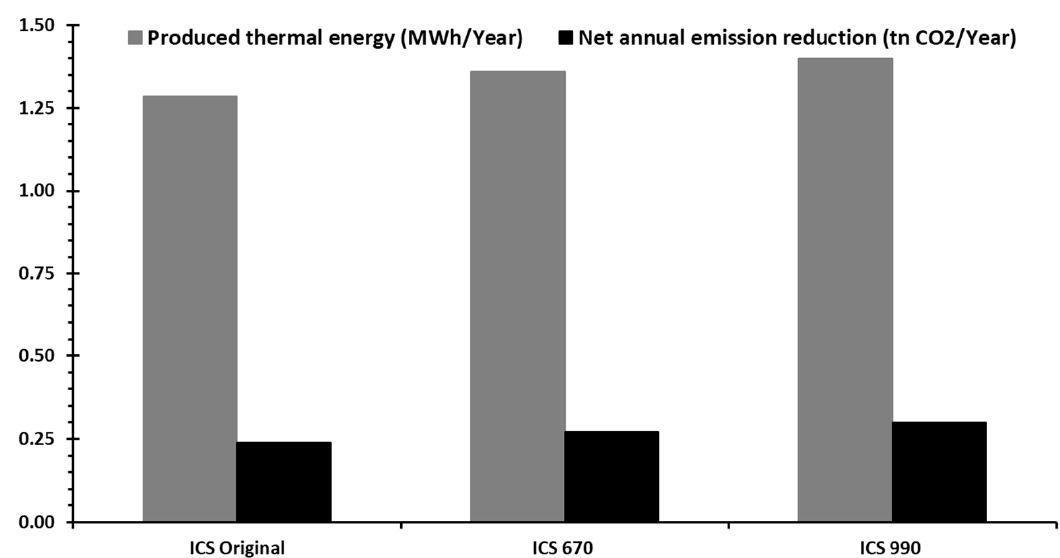
Figure 11. Aggregate results for the produced thermal energy and the net annual emissions reduction during operation mode of all the studied systems.